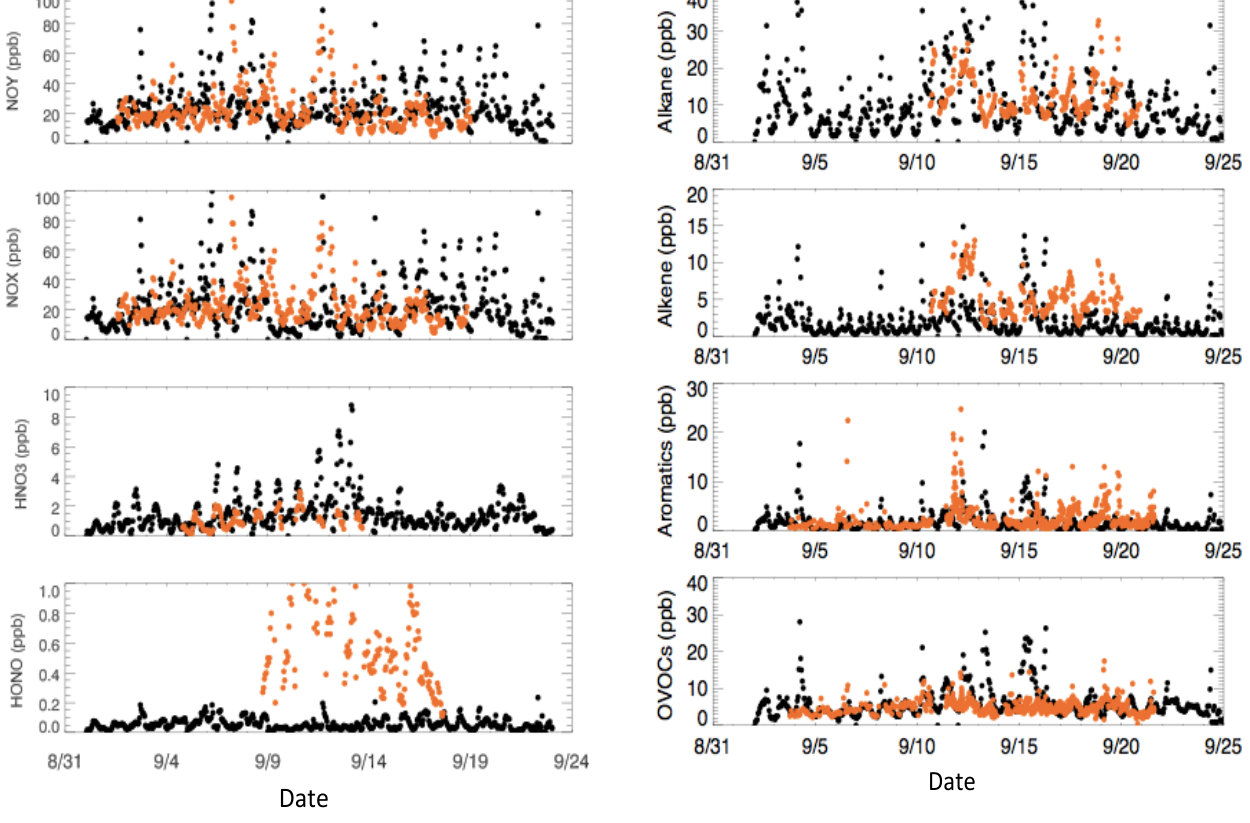
Fig. 4. The measured (orange dots) and calculated (black dots) tem- poral variability of NO y , NO x , HNO 3 , and HONO concentrations at PD station.